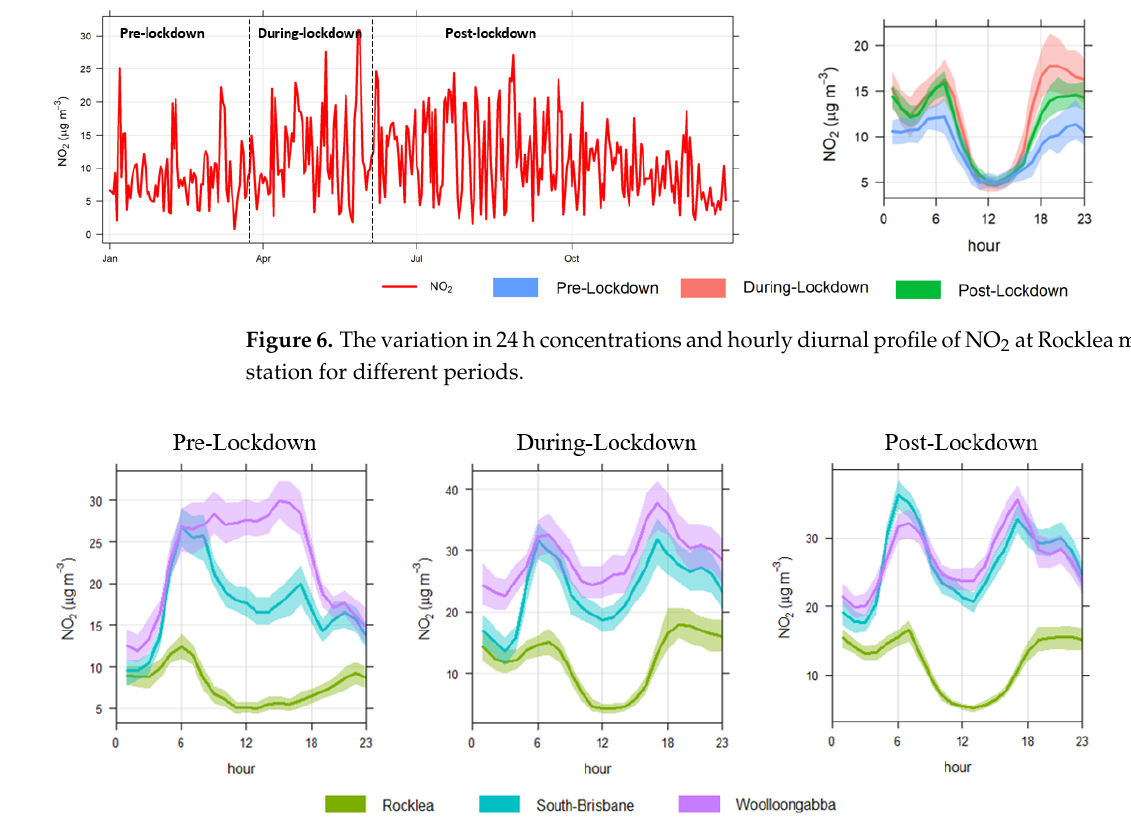
Figure 7. Hourly diurnal profile of NO 2 concentrations at different monitoring stations during various periods.